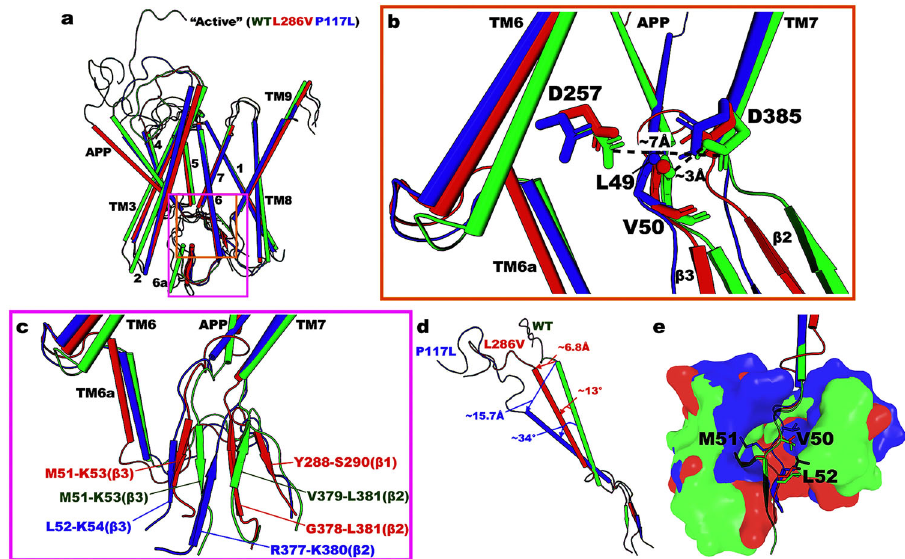
Fig. 2 The “ Active ” low-energy conformational state in the WT, L286V, and P117L PS1 FAD mutants of APP-bound γ -secretase. a The “ Active ” conformation of the APP-bound PS1 in WT (green), L286V (red), and P117L (blue) systems. b Active site of APP-bound PS1 in the “ Active ” WT, L286V, and P117L PS1. The distances between PS1 residues D257 and D385 are ~7.0 Å, ~7.0 Å, ~7.4 Å, and the distances between PS1 residue D385 and APP residue L49 are ~3.0 Å, ~2.9 Å, ~2.7 Å in the “ Active ” WT, L286V, and P117L γ -secretase, respectively. c Conformations of TM6a, TM7, and APP in the “ Active ” WT, L286V, and P117L PS1. d Conformations of the APP substrate in the “ Active ” WT, L286V, and P117L PS1. e Locations of APP substrate residues P1 ’ , P2 ’ , and P3 ’ in the “ Active ” WT, L286V, and P117L